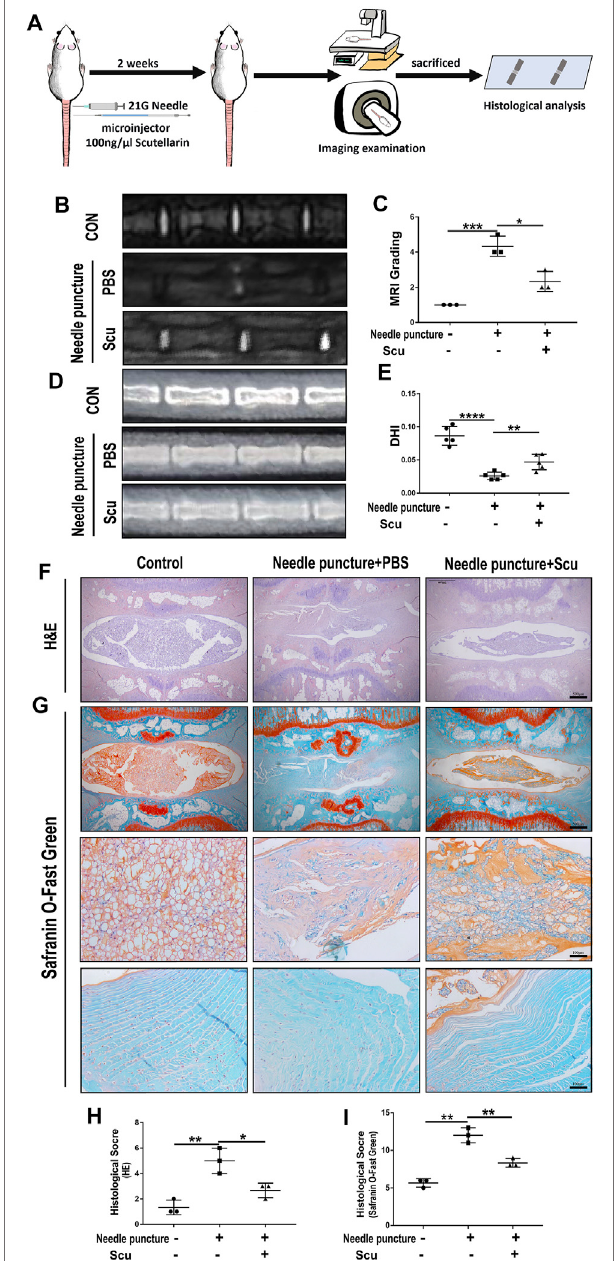
FIGURE 5 | Scutellarin improved the degeneration of IVD in a rat IVDD model. (A) Schematic of the in vivo experiment and coccygeal disc needle punctureinjections. (B,C) MRItoassessthedegreeofIVDDofCo6/7,7/8,8/9 inratsfromthecongroup( n =5),needlepuncture+PBSinjectiongroup ( n = 5) and needle puncture + scutellarin injection group ( n = 5). (D,E) X-ray was obtained to measure the height of the intervertebral space of Co6/7, 7/8, and 8/9 in rats from each indicated group. (F – I) HE and Safranin O staining were performed to evaluate the cellularity and morphological changes ofCo6/ 7, 7/8, 8/9 NPs in rats from each group. Then, the histological scores of each indicated group were calculated according to the grading scale previously published (scale bar: 500 μ m or 100 μ m). Each experiment was performed threetimesindependently.(* p < 0.05,** p < 0.01,*** p < 0.001,**** p < 0.0001).